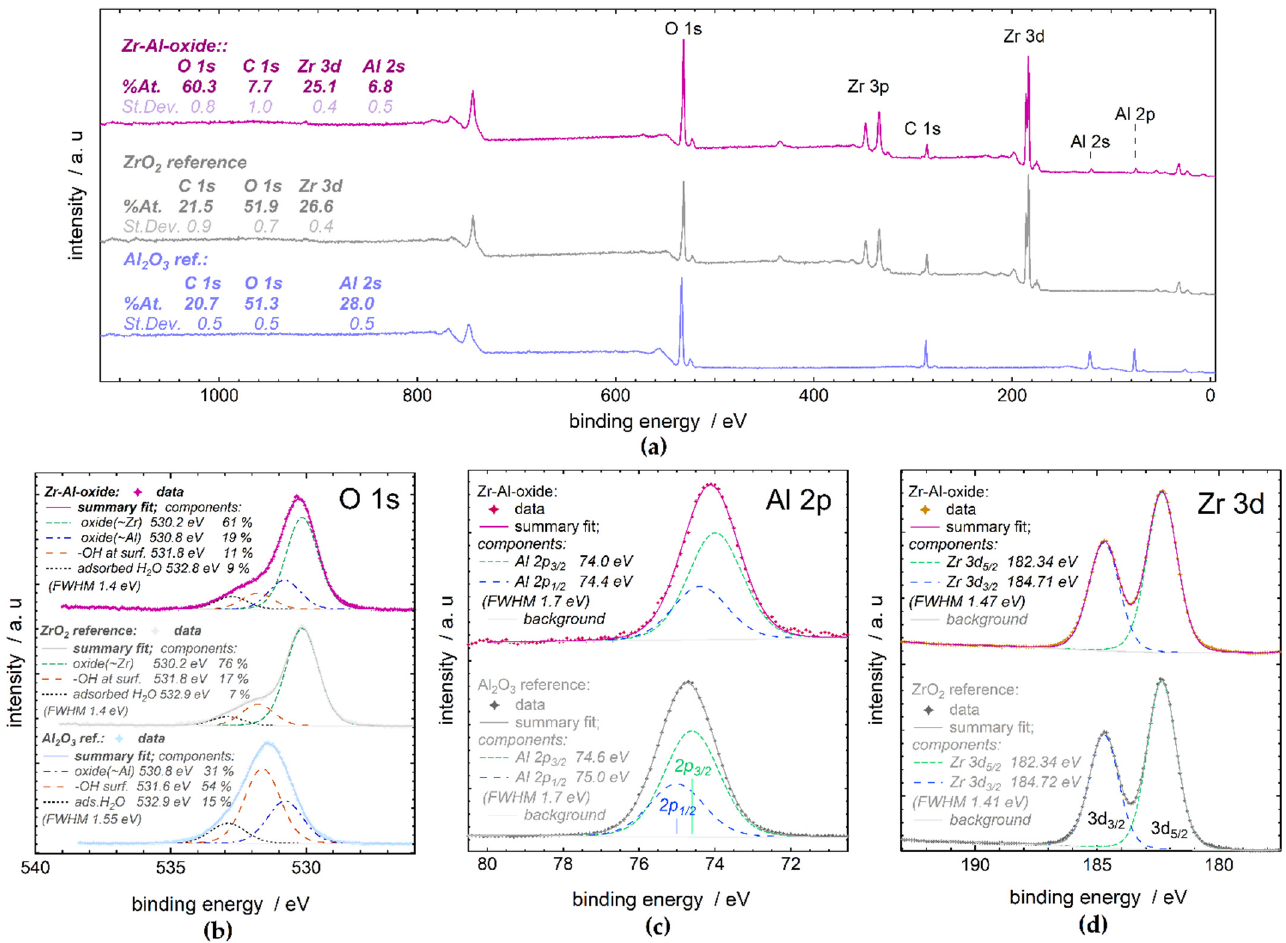
Figure 2. ( a ) Survey, ( b ) O1s, ( c ) Al 2p and ( d ) Zr 3d, X-ray photoelectron spectra of a Zr x Al y O z film grown using cycle sequence of 80 × (ZrCl 4 + Al(CH 3 ) 3 + H 2 O), and reference ZrO 2 and Al 2 O 3